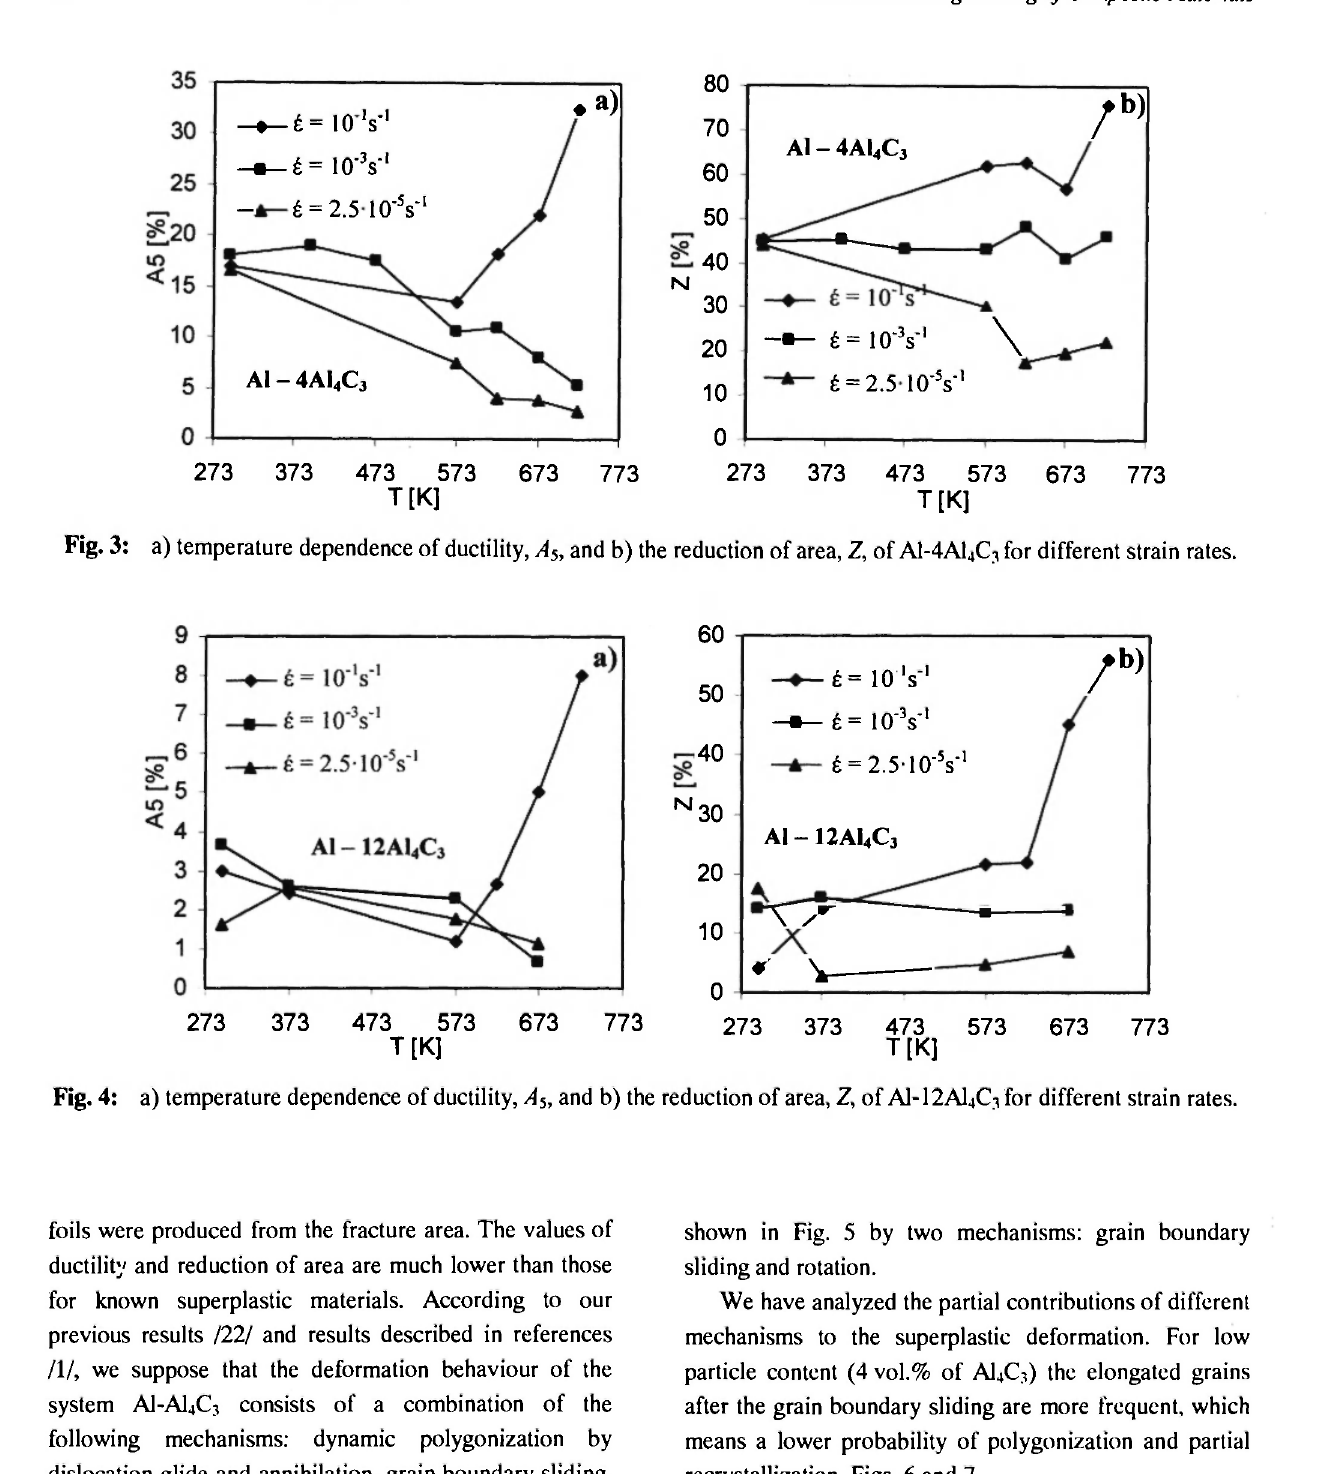
Fig. 4: a) temperature dependence of ductility, A 5 , and b) the reduction of area, Z, of AI-I2AI4C3 for different strain rates.